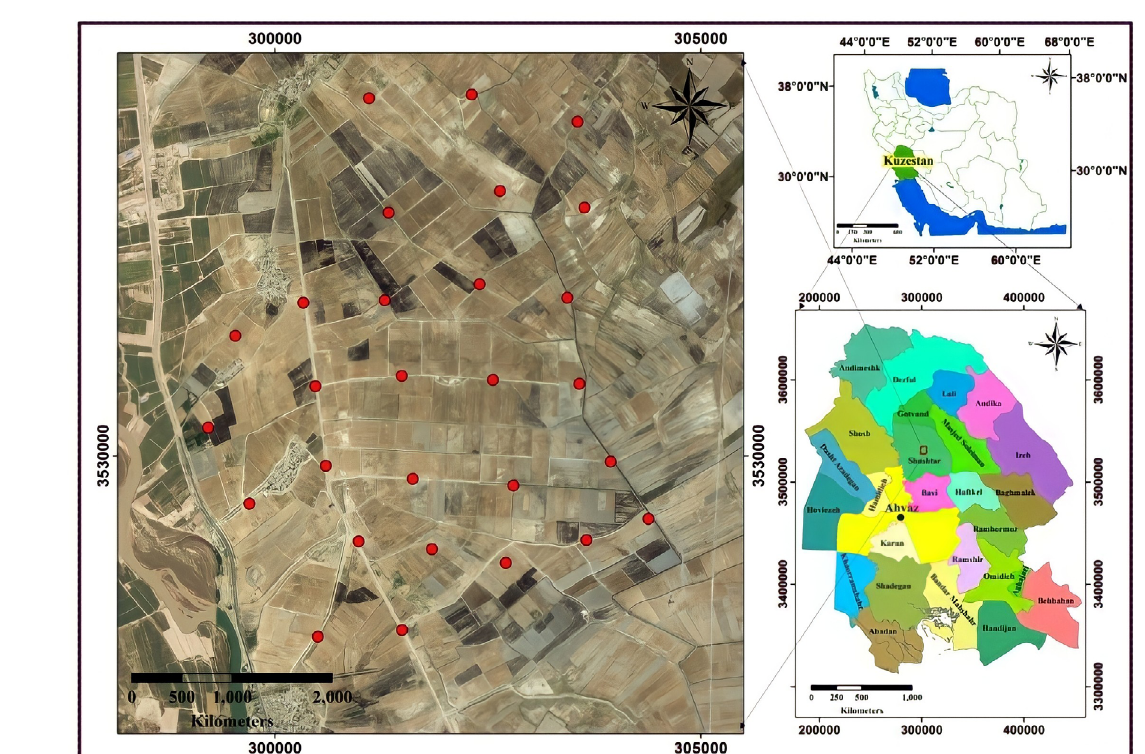
Figure 2. Geographical location of the sampling site of the